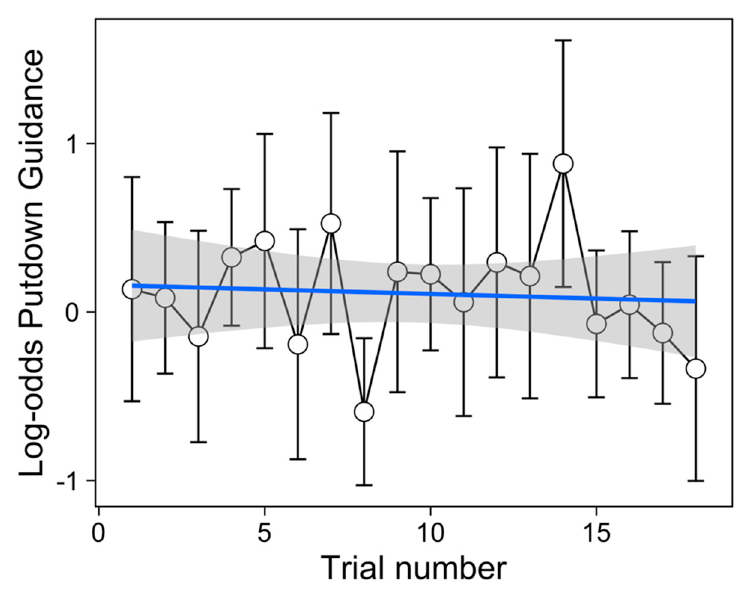
Figure 4. Change in GLMM calculated Log-odds of guided putdowns (for putdown 1) over trials in the experiment, with 95% CI. The linear fit is overlaid with shaded standard errors. Individual plots for each participant are shown in Appendix A Figure A2.